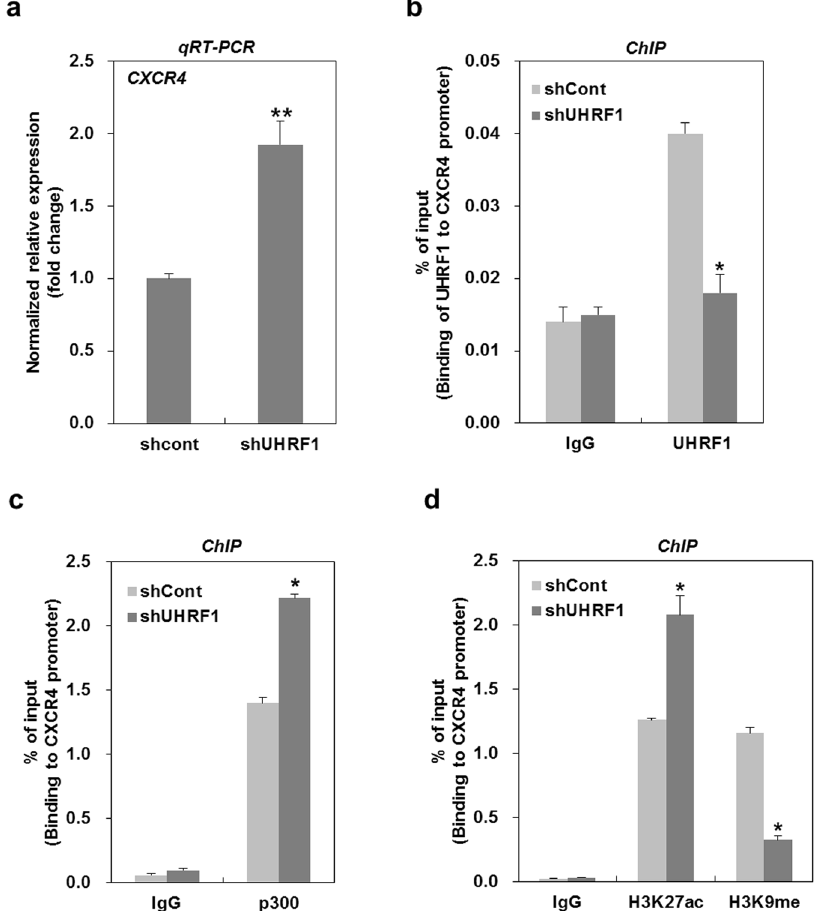
Figure 3. Downregulation of UHRF1 leads to upregulation of CXCR4 via epigenetic modulation. ( a ) qRT-PCR analysis for the mRNA expression level of CXCR4 in shCont- and shUHRF1-HepG2 cells. ( b ) ChIP analysis for the presence of UHRF1 on the CXCR4 promoter in shCont- or shUHRF1-HepG2 cells. Chromatin was immunoprecipitated with an anti-UHRF1 antibody. ( c ) ChIP analysis for the presence of p300 on the CXCR4 promoter in shCont- or shUHRF1-HepG2 cells. Chromatin was immunoprecipitated with an anti-p300 antibody. ( d ) ChIP analysis for the presence of H3K27ac and H3K9me on the CXCR4 promoter in shCont- or shUHRF1-HepG2 cells. Chromatin was immunoprecipitated with an anti-H3K27ac or -H3K9me antibody. The results show the percentage of the input chromatin (1%). IgG was used as the antibody control. Results from three independent experiments are expressed as means ± SEMs. ( * P < 0.05, ** P <